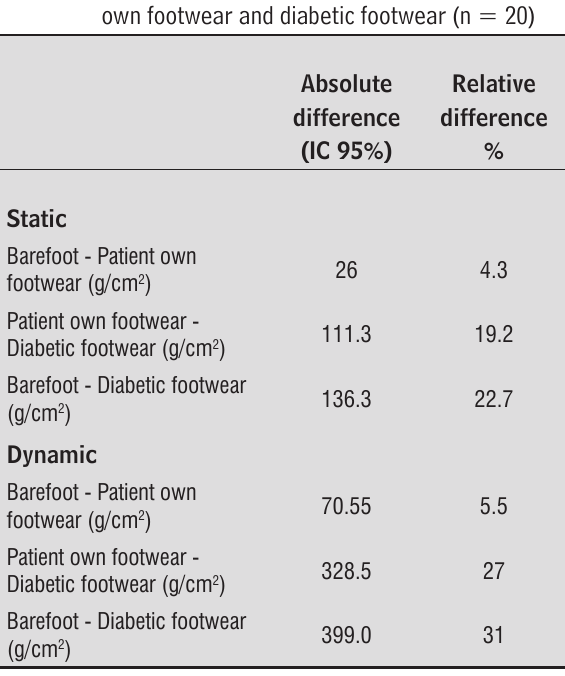
Table 2 - Absolute and relative mean difference of peak plantar pressure comparing barefoot,